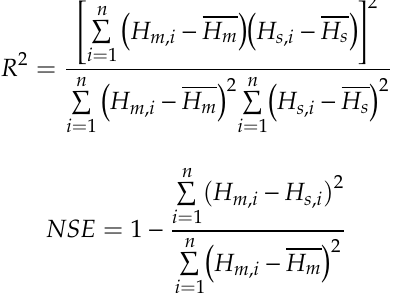
Figure 2. Schematic of river channel between the Three Gorges Dam (TGD) and the Gezhouba Dam (GZD).